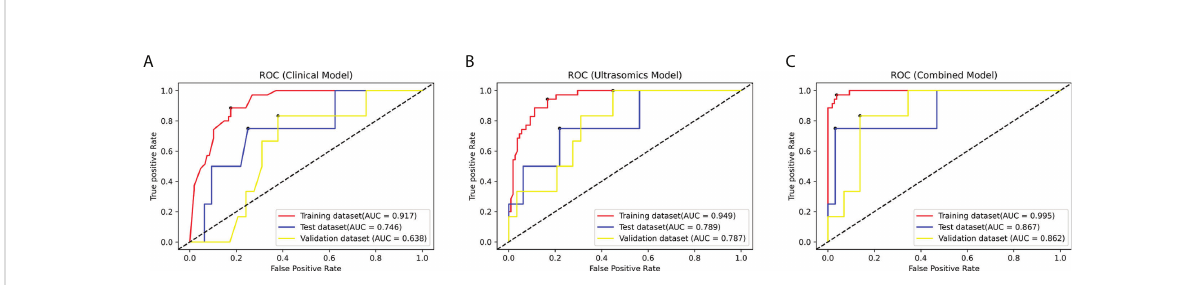
FIGURE 4 The ROC curves of the modes in the training dataset, test dataset and validation dataset: (A) The clinical model. (B) The ultrasomics model. (C) The combined